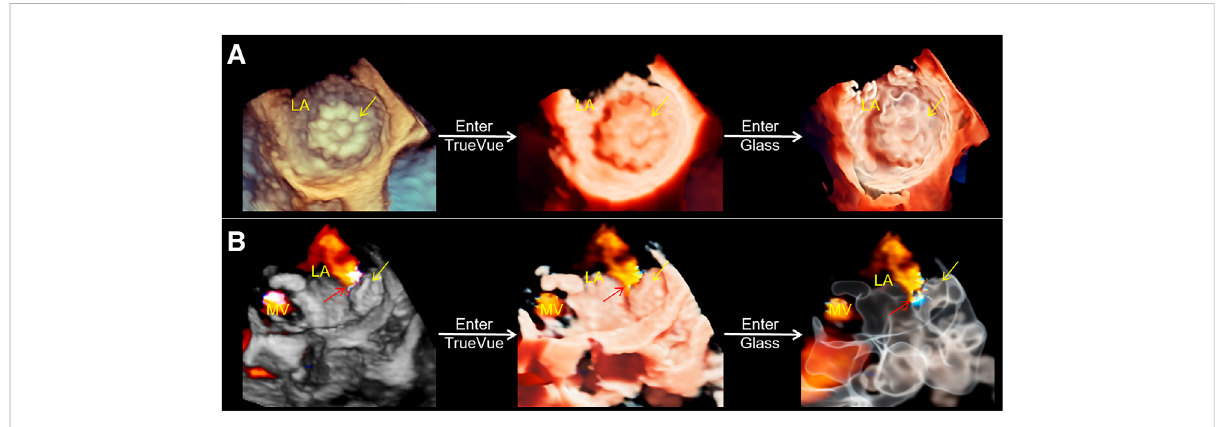
FIGURE 5 Three-dimensional transesophageal echocardiography plus color Doppler for outcome assessment after left atrial appendage occlusion. (A) . From lefttoright,conventional3D,TrueVue andTrueVueGlass directviews oftheleftatriumappendageoccluder (yellow arrows) aredisplayed. (B) . From left to right, conventional 3D, TrueVue and TrueVue Glass with color Doppler showing the residual shunt (red arrows) around the occluder (yellow arrows), among them, TrueVue Glass showing the origin and path of the shunt more entirely. LA, left atrium; MV, mitral